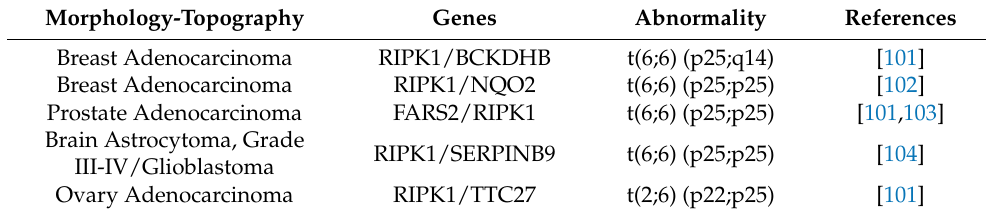
Table 3. RIPK1 fusion gene involved in tumorigenesis Morphology-Topography Genes